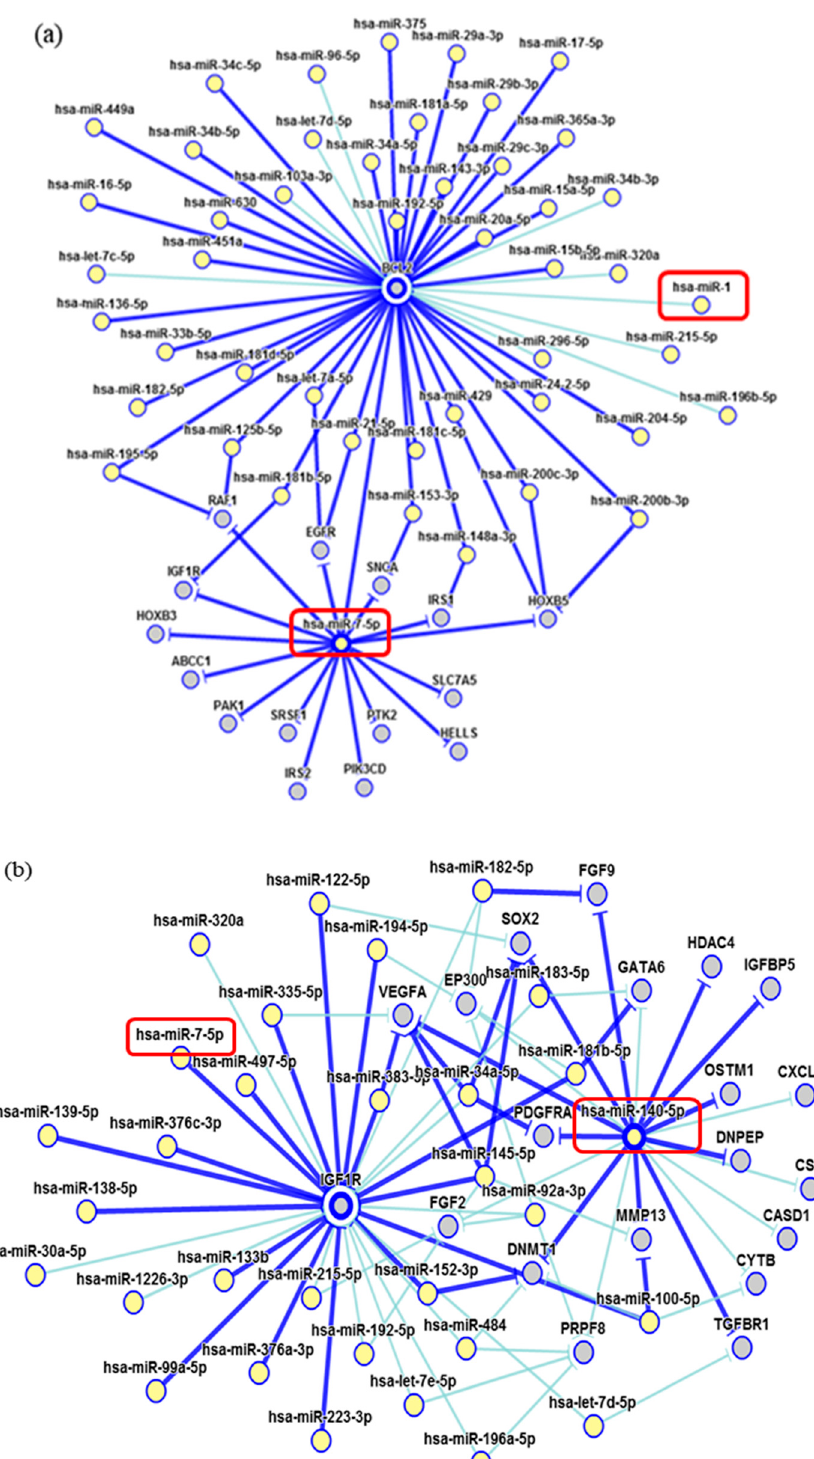
Figure 8. Interaction network of miRNAs. ( a ) miR-1 showed a weak modulation of BCL2; ( b ) miR-140-5p strongly interact with VEGFA. Dark blue shows strong evidence (reporter assay, Western blot, qRT-PCR or qPCR), and light blue shows other evidence.